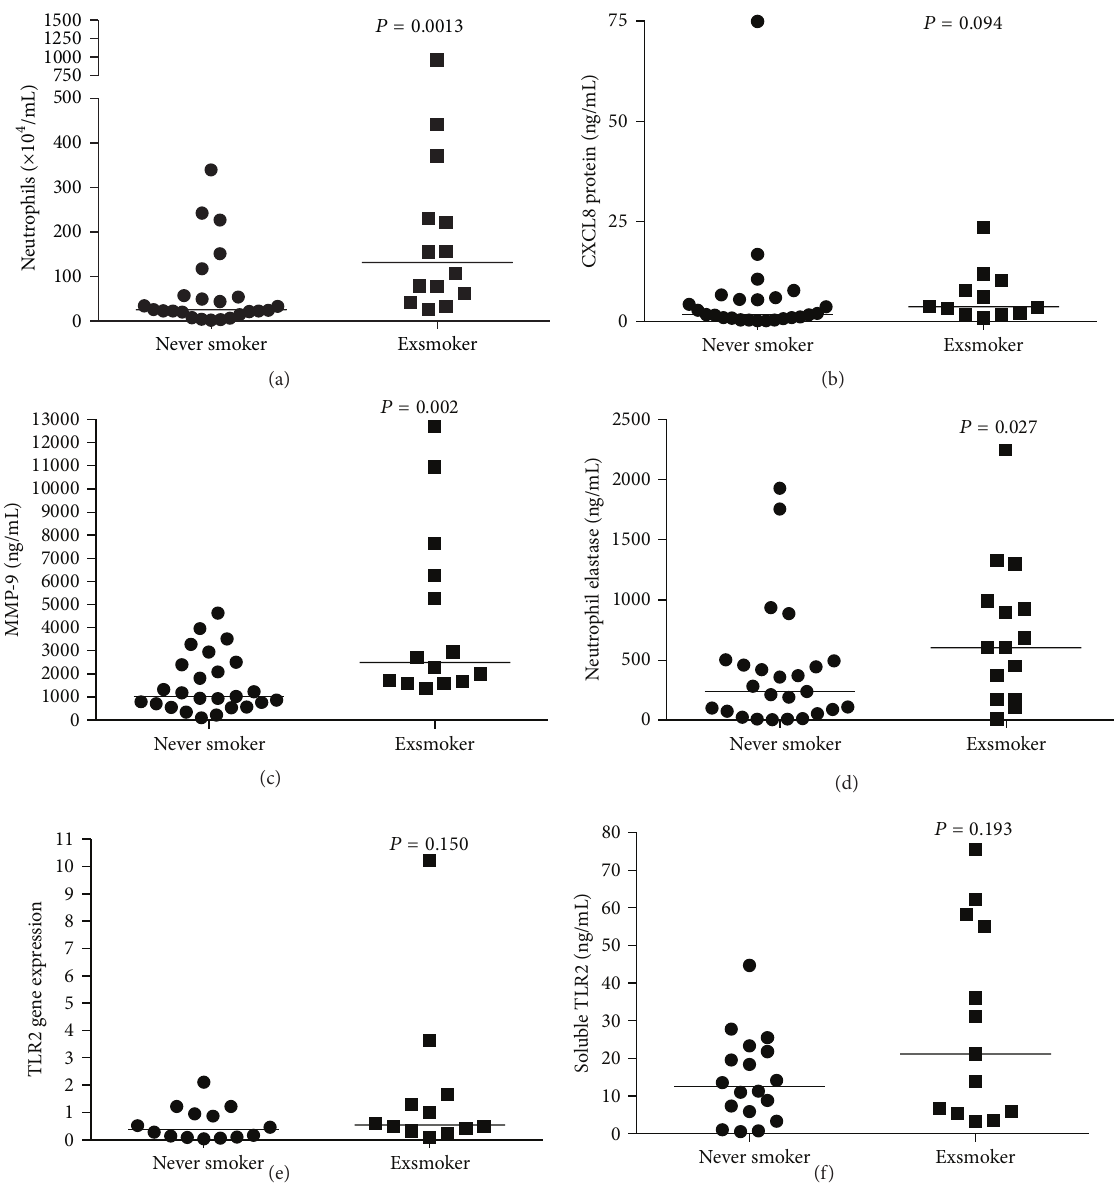
Figure 2: Analysis of the effect of smoking on markers of neutrophilic airway inflammation. This analysis used healthy controls, comparing never smokers with exsmokers. (a) Neutrophil number × 10 4 /mL, (b) CXCL8 protein ng/mL, (c) MMP-9 protein ng/mL, (d) NE protein ng/mL, (e) TLR2 gene expression, and (f) soluble TLR2